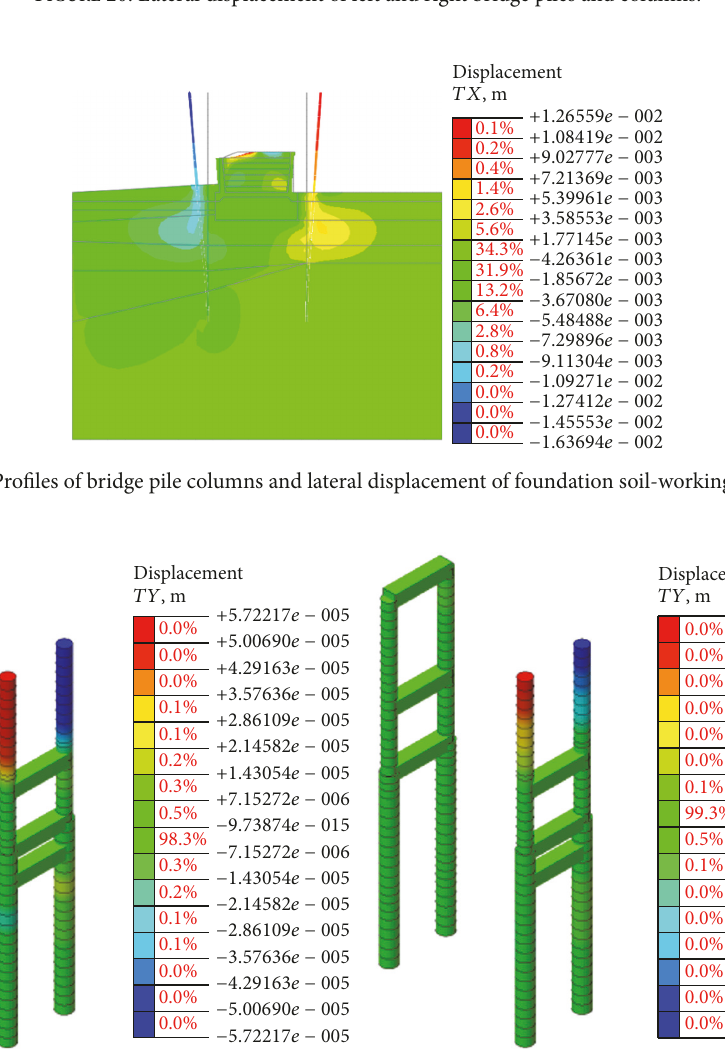
Figure 20: Lateral displacement of left and right bridge piles and columns.